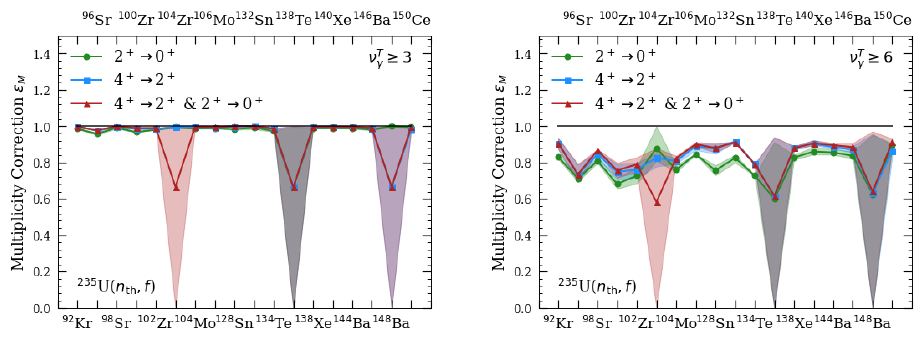
≥ 3 (left) and ν T ≥ 6 (right) for several γ γ